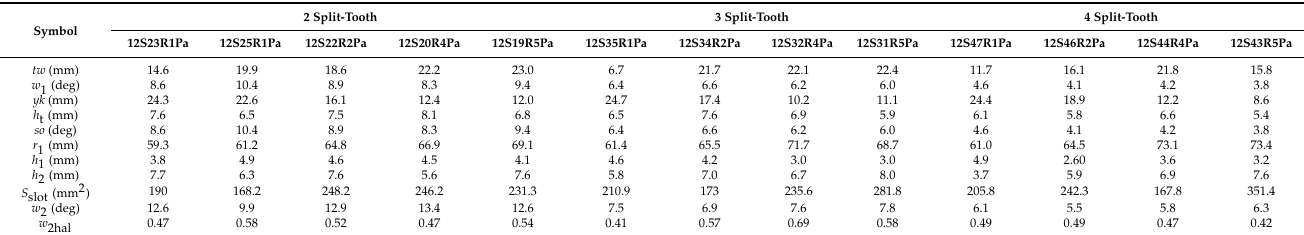
Figure 10. Torque waveforms of 12S1Pa STDPM machines. Table 3. Parameters of optimized 12-slot STDPM machines with a different split-tooth number and armature pole pair number.